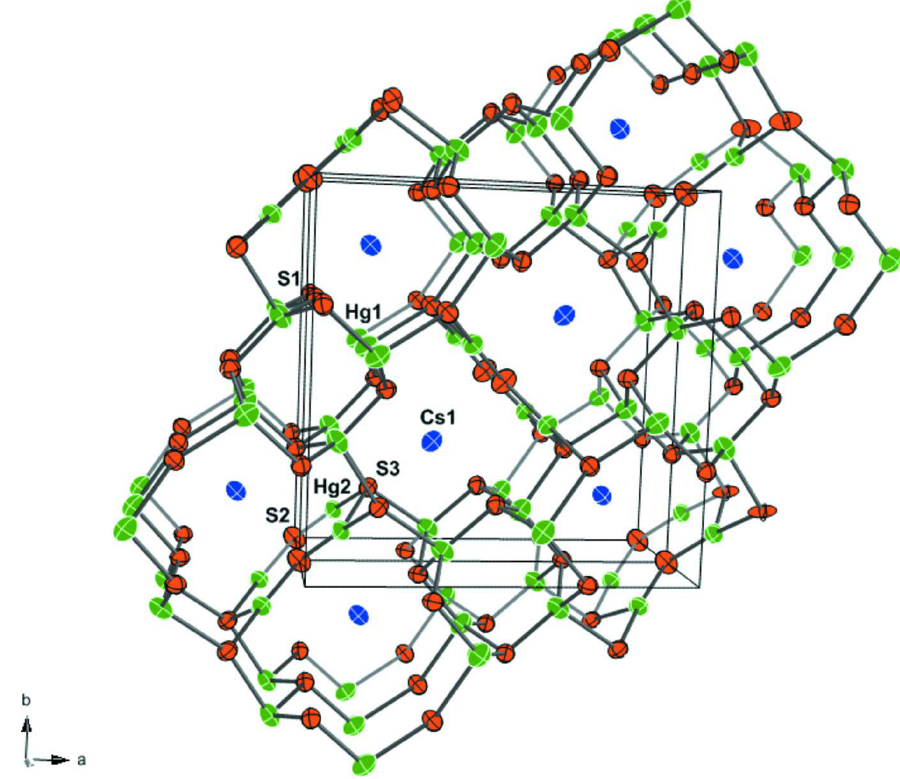
Figure 1 A view down [001] of the unit cell of Cs Dicaesium hexamercury heptasulfide Crystal